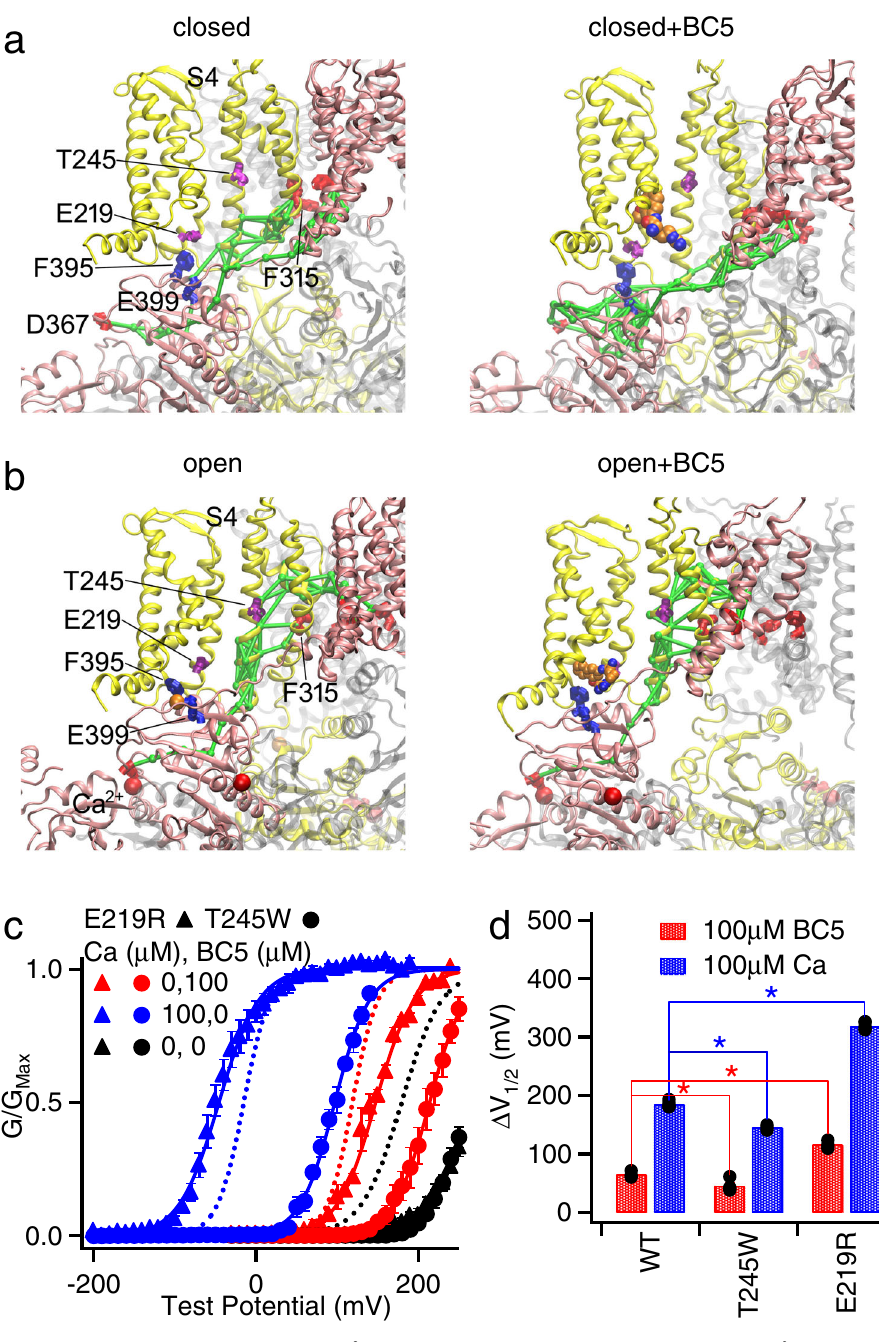
Fig. 4 | BC5 interactions with the allosteric pathway for coupling Ca 2+ binding T245W, 260.9±6.8 and 21.1±5.3 at 0 [Ca 2+ ] i and 0 BC5 (black circle, n =6); toporeopening.a , b OptimalandsuboptimalpathwayscouplingCa 2+ -bindingsite 213.8±2.9 and 22.1±2.8 W at 0 [Ca 2+ ] i and 100 µ M BC5 (red circle, n =7); and D367 and pore lining residue F315. A similar region as in Fig. 1a is shown. The two 106.0±3.3and21.2±3.1at100 µ M[Ca 2+ ] i and0BC5(bluecircle, n =3).Dashedlines are taken from Fig. 3c for WT at0 [Ca 2+ ] i and 0 BC5 (black); at 0 [Ca 2+ ] i and 100 µ M neighboring subunits forming the VSD-CTD contacts are colored in pink and yel- low, respectively. The pathways are represented in green sticks. c GV relationship BC5(red);andat100 µ M[Ca 2+ ] i and0BC5(blue). d GVshiftcausedby100 µ M[Ca 2+ ] i (blue, n =6forWT, n =3forT245Wand n =6forE219R)and100 µ MBC5(red, n =3 and Boltzmann fi ts (solid lines) of the mutant channels E219R (results are shown for WT, n =4 for T245W and n =3 for E219R). Individual data points are shown in with triangles) and T245W (results are shown with circles). V 1/2 and slope factor (mV): for E219R, 263.7±8.7 and 30.4±6.8 at 0 [Ca 2+ ] i and 0 BC5 (black triangles, solidcircles.Bothmutationsaresigni fi cantlydifferentinGVshiftcausedby100 µ M µ MBC5(redtriangles, n =3);and n =5);147.4±4.7and23.6±4.1at0[Ca 2+ ] [Ca 2+ ] i and 100 µ M BC5, respectively, compared to WT with P<0.05, one-way i and100 -51.5±4.2mV and 24.7±3.5 at 100 µ M [Ca 2+ ] i and 0 BC5 (blue triangles, n =6); for Tukey – Kramer ANOVA test was